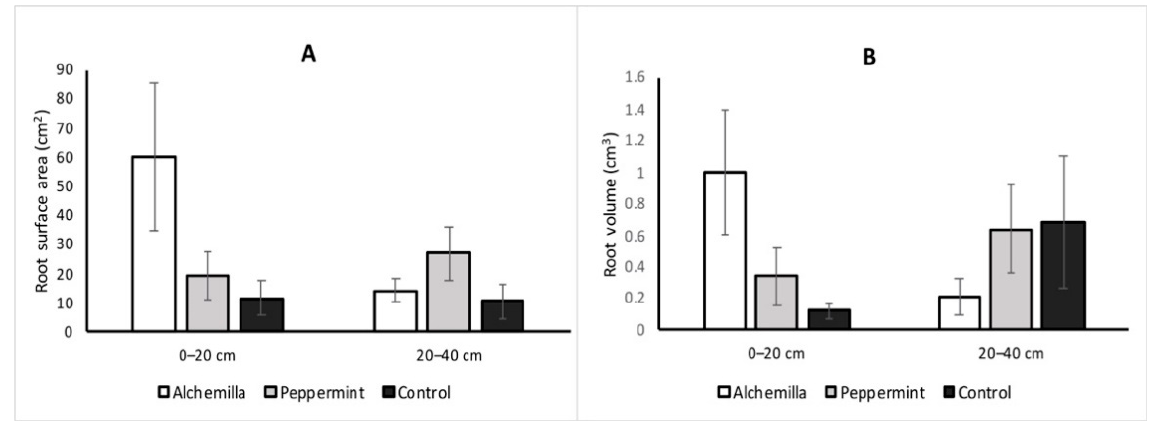
Figure 5. Interaction effect of treatment and soil depth on apple root surface area (cm 2 ) ( A ) and root volume (cm 3 ) ( B ). Bars represent the SEM.